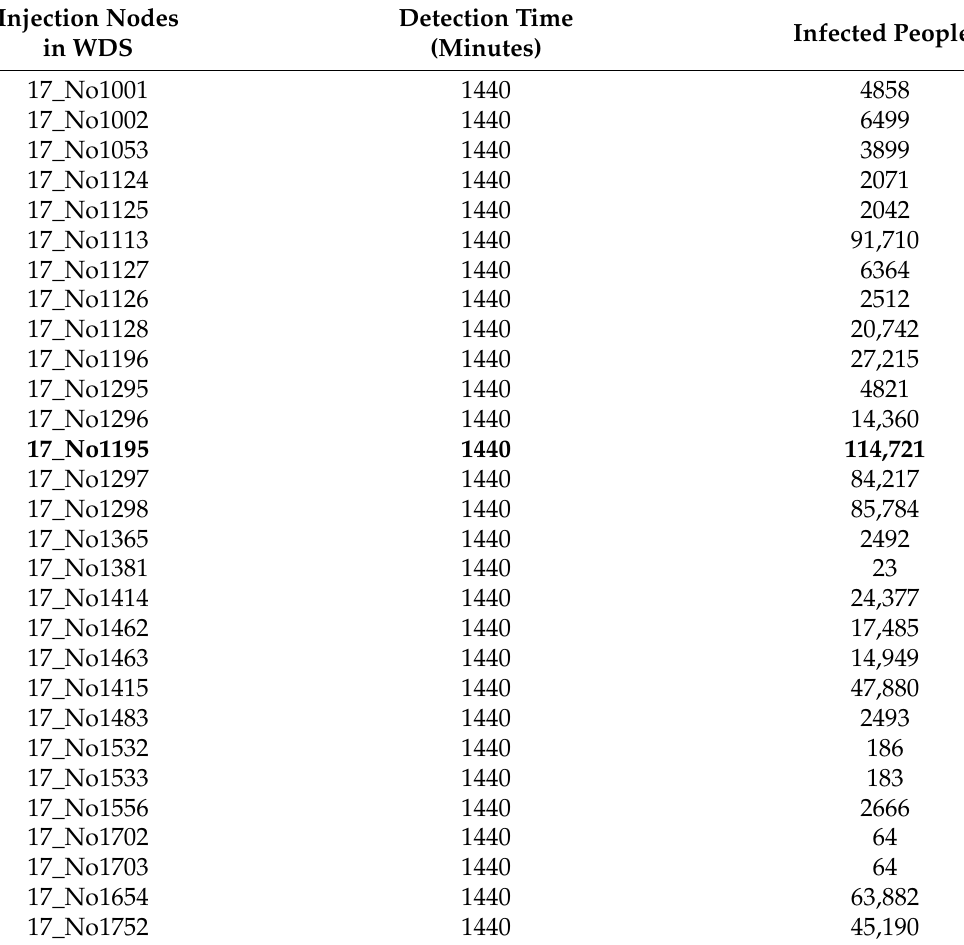
Table 3. Health impact without using any water quality monitor